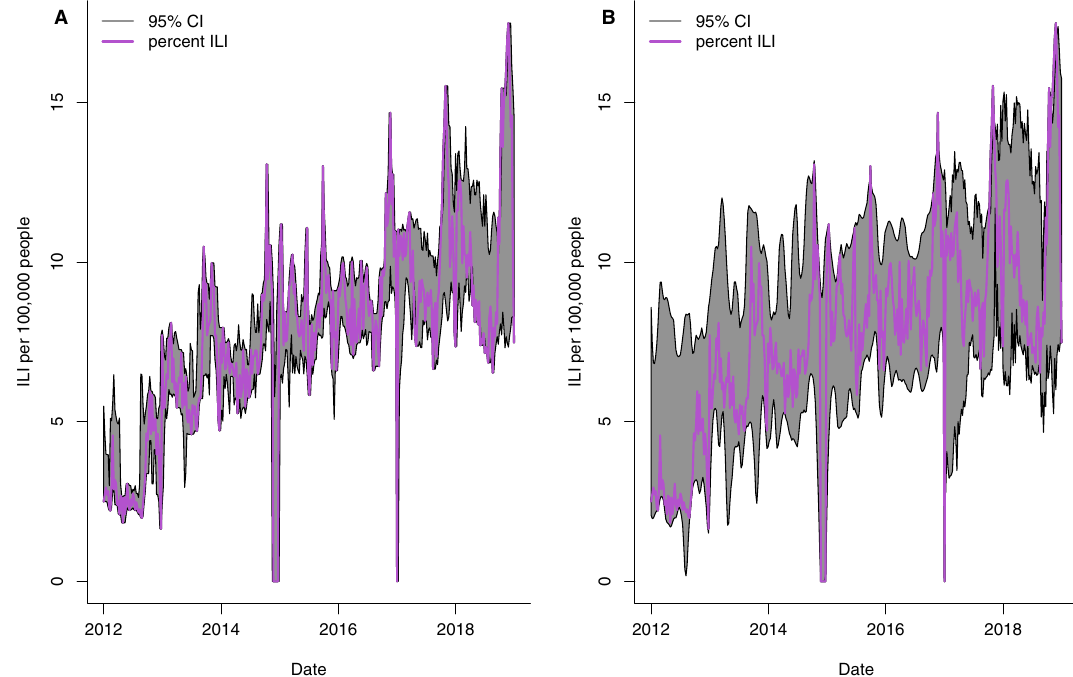
Figure 5. 95% Confidence Intervals (CI) for 1-week-ahead predictions of rate of ILI per 100,000 inhabitants at the national level. Models were fit using five years of data; week 1 to 261. Forecasts for the next week, t + 1, were made at week, t. Estimates using (A) Random Forest Regression and (B) Support Vector Machine Regression (SVM) are presented.